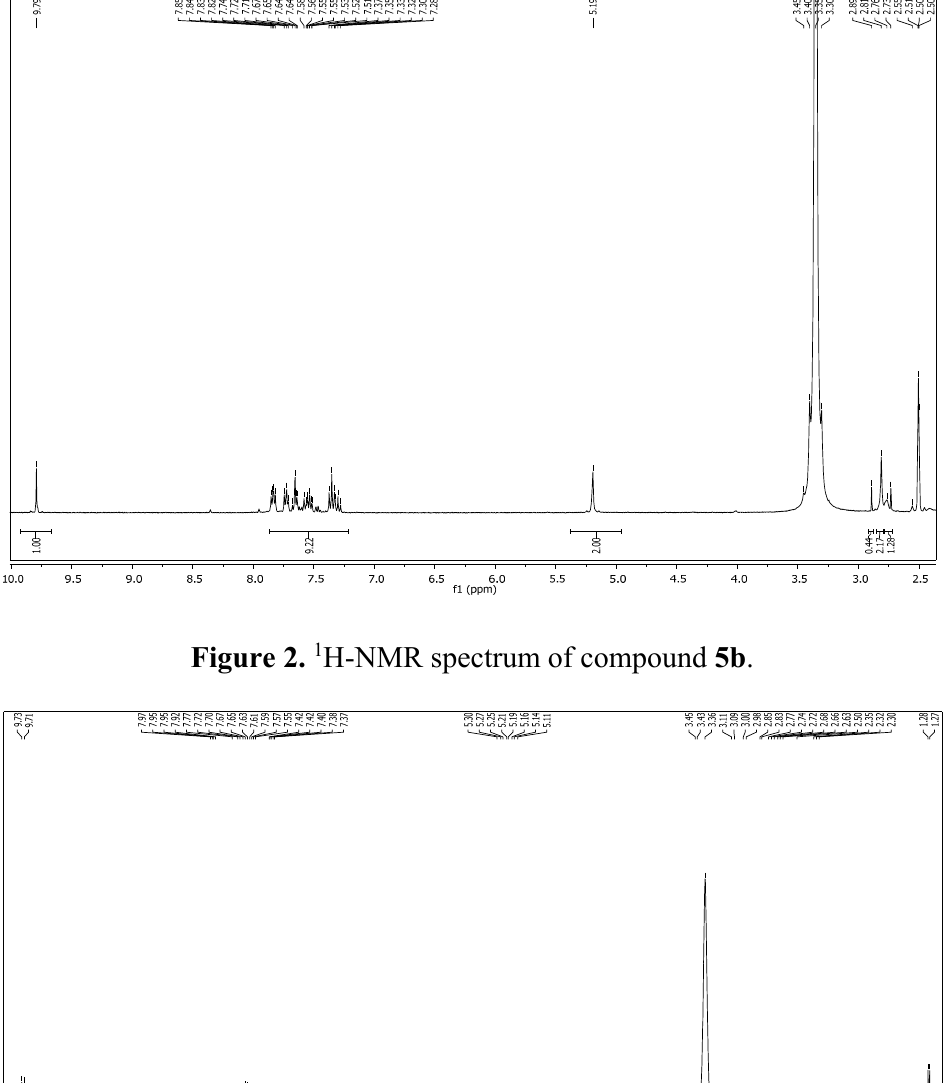
Figure 1. 1 H-NMR spectrum of compound 4a .